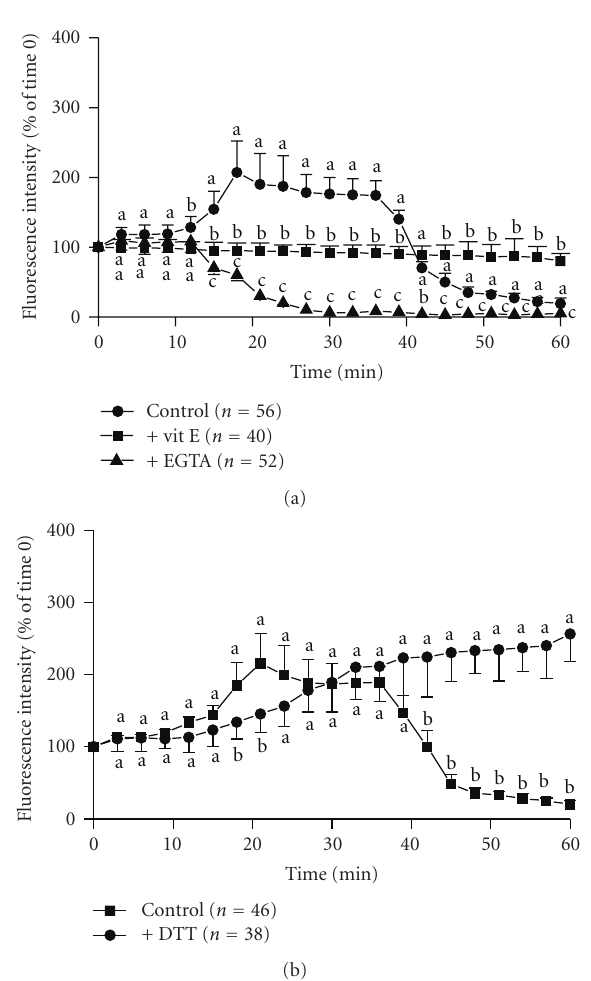
Figure 3: The e ff ect of vitamin E and DTT on the concentration of intracellular calcium in TBH-treated hepatocytes. (a) Changes in concentration of intracellular calcium were determined in the cells treated with 2.0mM TBH (control), with 2.0 mM TBH by the pretreatment with 100 μ M vitamin E for 20 h, or with 15mM EGTA for 15min. (b) Changes in concentration of intracellular calcium were determined in the cells treated with 2.0mM TBH (control) or with 2.0 mM TBH by the pretreatment with 5.0mM DTT for 15min. The results were based on three separate experiments, and the values are expressed as mean ± SD. Treatment means in the same time not sharing the same superscripts di ff er significantly ( P < .